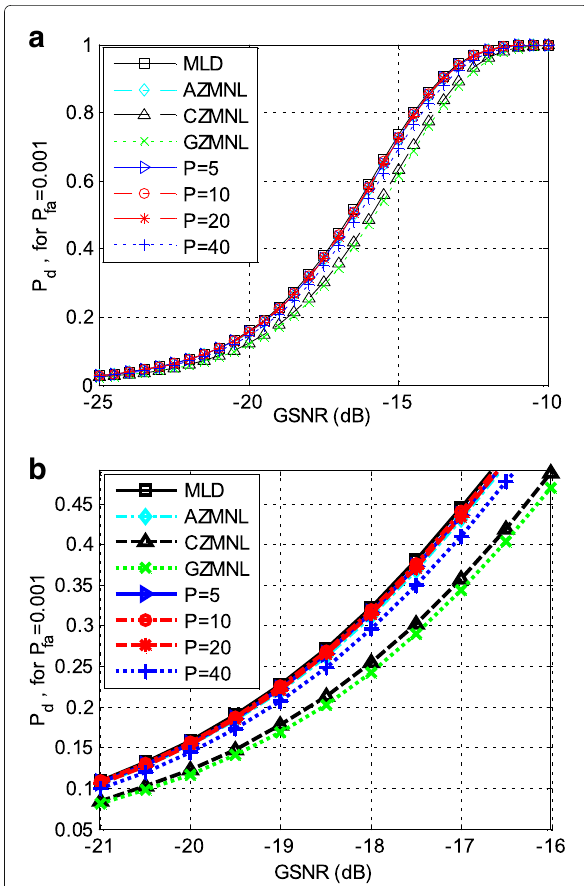
Fig. 3 Detection probability versus the GSNR, for α = 1.5, P fa = 0.001: a curves for GSNR between − 25 and − 10 dB, b details for GSNR between − 21 and − 16 dB Fig. 4 Detection probability versus the GSNR, for α = 1.0, P fa =